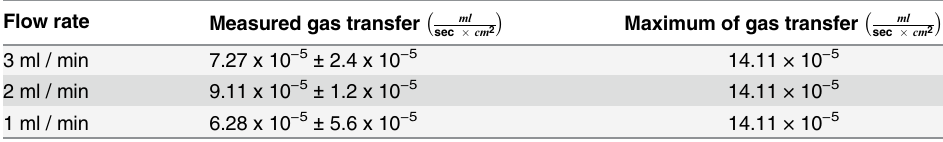
Table 6. Gas transfer of uncoated Lumox ™ slide after redesign. Flow